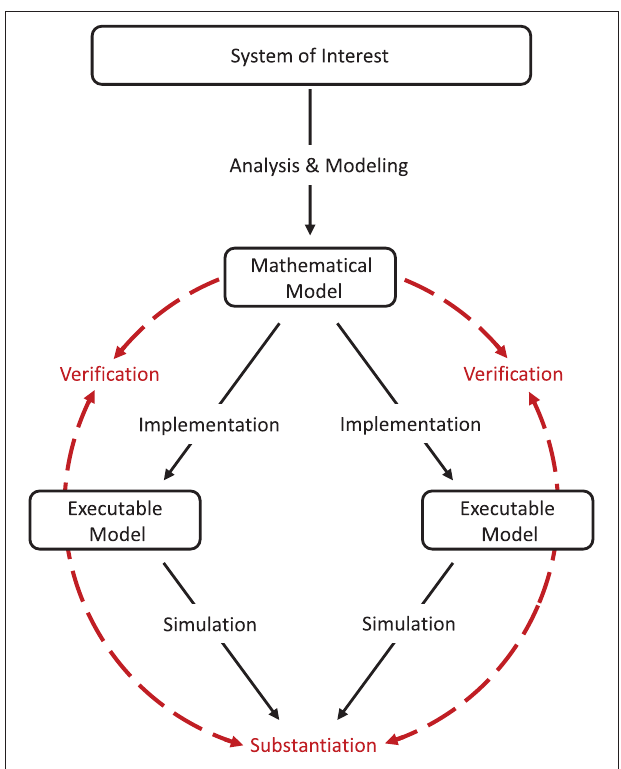
FIGURE 2 | Model verification and substantiation workflow. The workflow shown is an adaption of the verification and validation processes ( Figure 1 ) for the comparison of two executable models (i.e., a model-to-model validation test). The executable models share the same system of interest and the same mathematical model, but differ in the model implementation (e.g., by using different simulation engines). We propose the term “substantiation” instead of “validation” to indicate that this assessment activity cannot evaluate the accuracy of the model with respect to its system of interest. Modeling and simulation activities are indicated by black solid arrows, whereas assessment activities are indicated by red dashed arrows. Figure amended from Trensch et al. (2018)